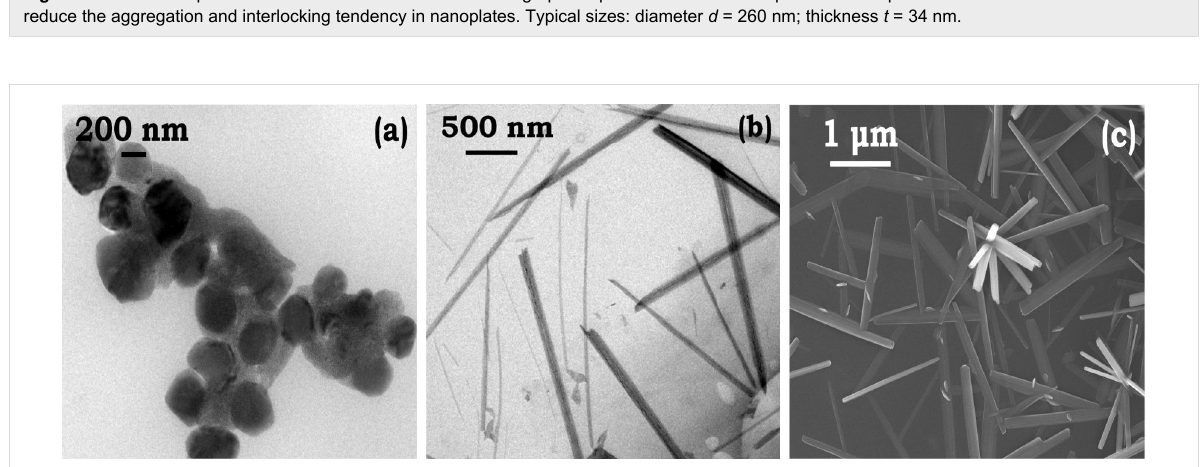
Figure 5: FEGTEM micrographs of cobalt-TMAH rods synthesized at 50 °C. (a) FEGTEM micrograph captured after 15 min, size = 105 nm; (b) FEGTEM micrograph captured after 45 mins, length 0 1400 ± 8 nm, diameter = 110 ± 3 nm. The cobalt rods formed by directional aggregation of nanoparticles obtained after 15 min. (c) FEGSEM micrograph of cobalt rods shows that rods are connected at 90°, however, a few nanorods are iso- lated as